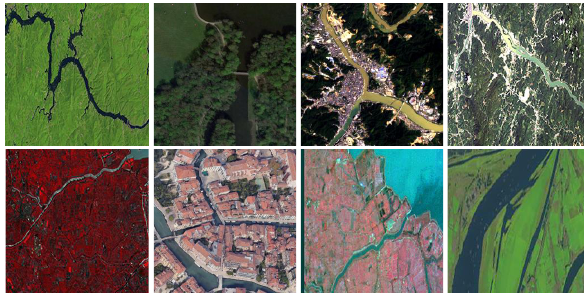
Figure 7. Partial sample display of water area dataset.